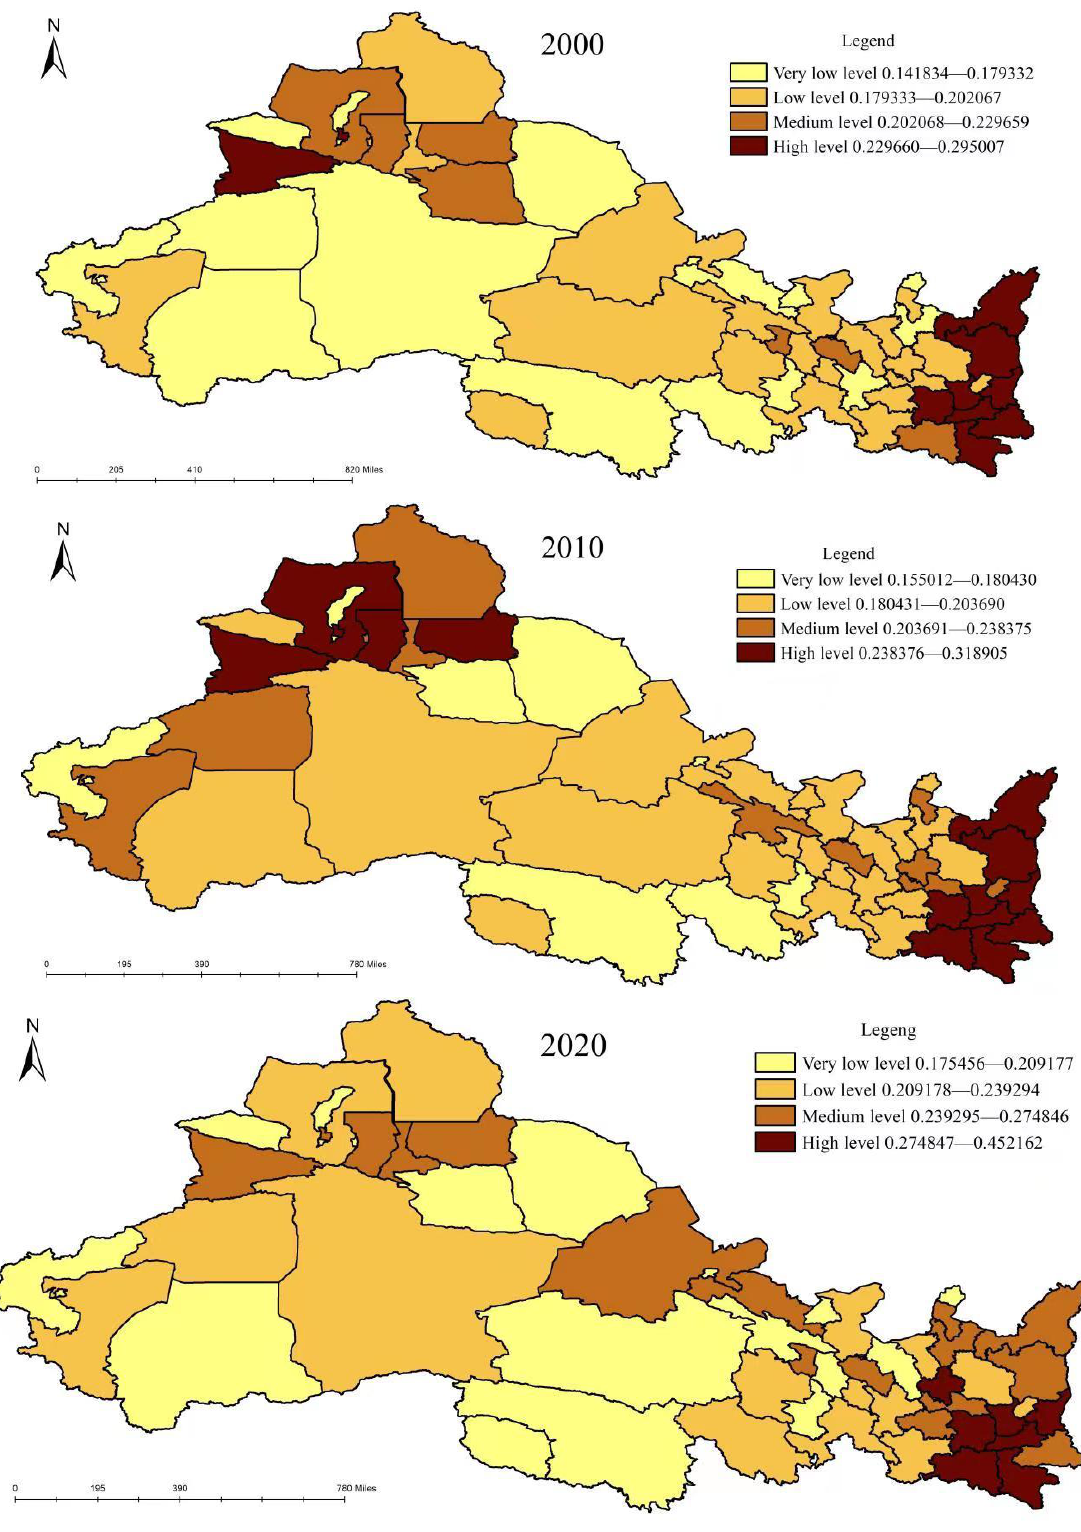
Figure 3. Rural water poverty level in northwest China from 2000 to 2020.